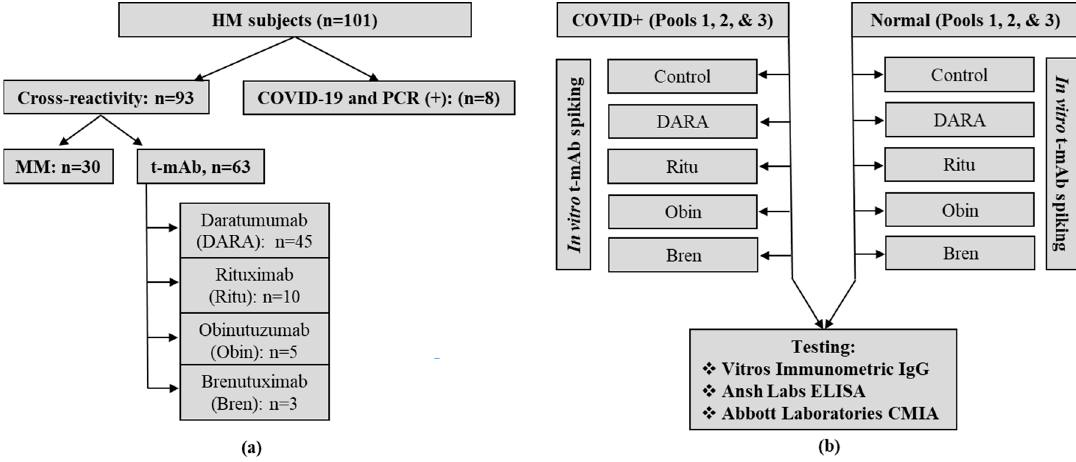
Figure 1. ( a ) Flowchart of severe acute respiratory syndrome coronavirus 2 (SARS-CoV-2) serology cross-reactivity testing study cases. Hundred and one unique hematological malignancy (HM) patient samples were included in SARS-CoV-2 serology testing. Eight of those were coronavirus disease 2019 (COVID-19)-positive by PCR, 30 were multiple myeloma (MM) patients and the remaining HM patients were on therapeutic monoclonal antibody (t-mAb) treatments. ( b ) Flowchart to assess the degree of interference in three SARS-CoV-2 serology assays due to different therapeutic monoclonal antibodies in normal and COVID-19 + samples by supplementing/spiking with respective antibodies in vitro. Pooled samples from normal and COVID-19 + patients were spiked with the clinically relevant concentration of each of the four therapeutic monoclonal antibodies—DARA (0.5 g / L), Ritu (0.5 g / L), Obin (0.5 g / L) and Bren (0.15 g / L)—or equal volume of saline for controls. These specimens then underwent analysis for the respective COVID-19 serology assays. Three pooled samples were used in each group (n =